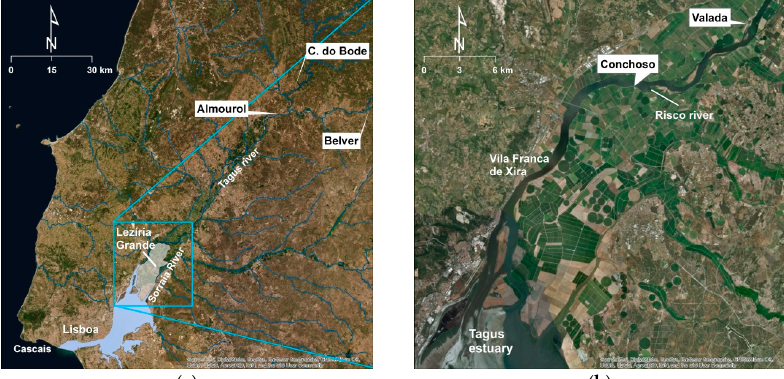
Figure 1. Global perspective of the Tagus estuary ( a ) and detail of the study area in the upper estuary ( b ). Location of the stations. Source of the background image: ESRI Basemap.